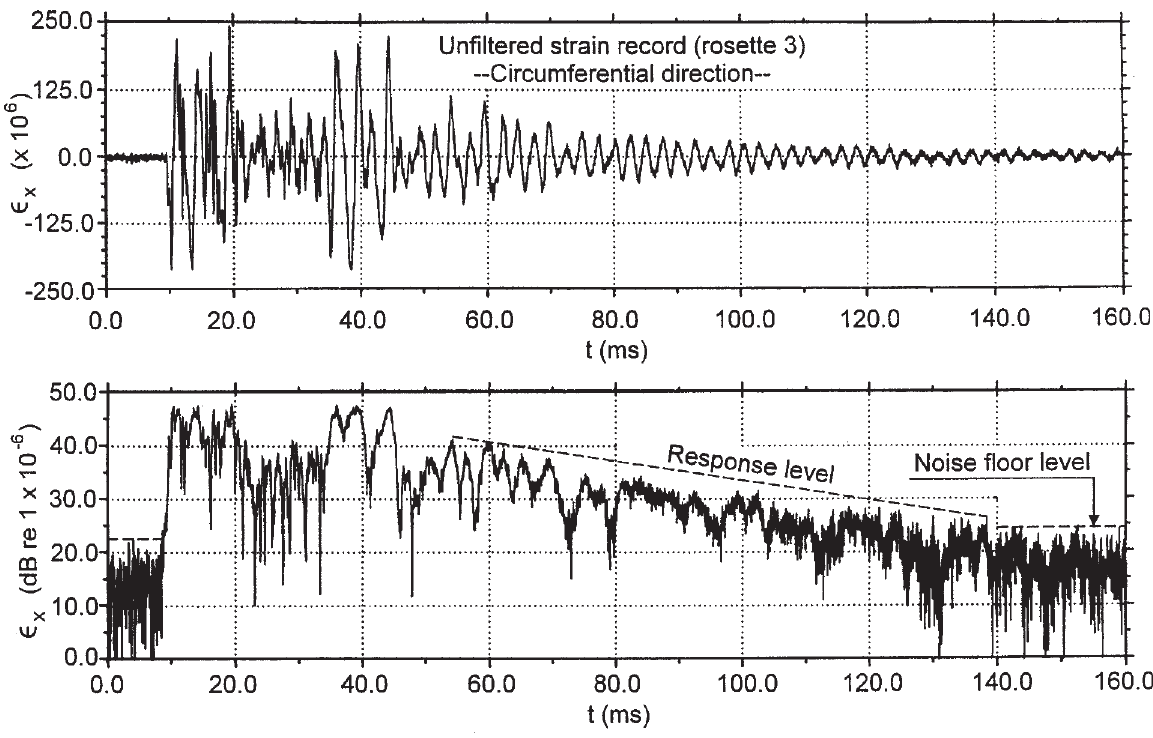
Fig. 7. Magnitude function of a typical strain record (rosette 3) – circumferential